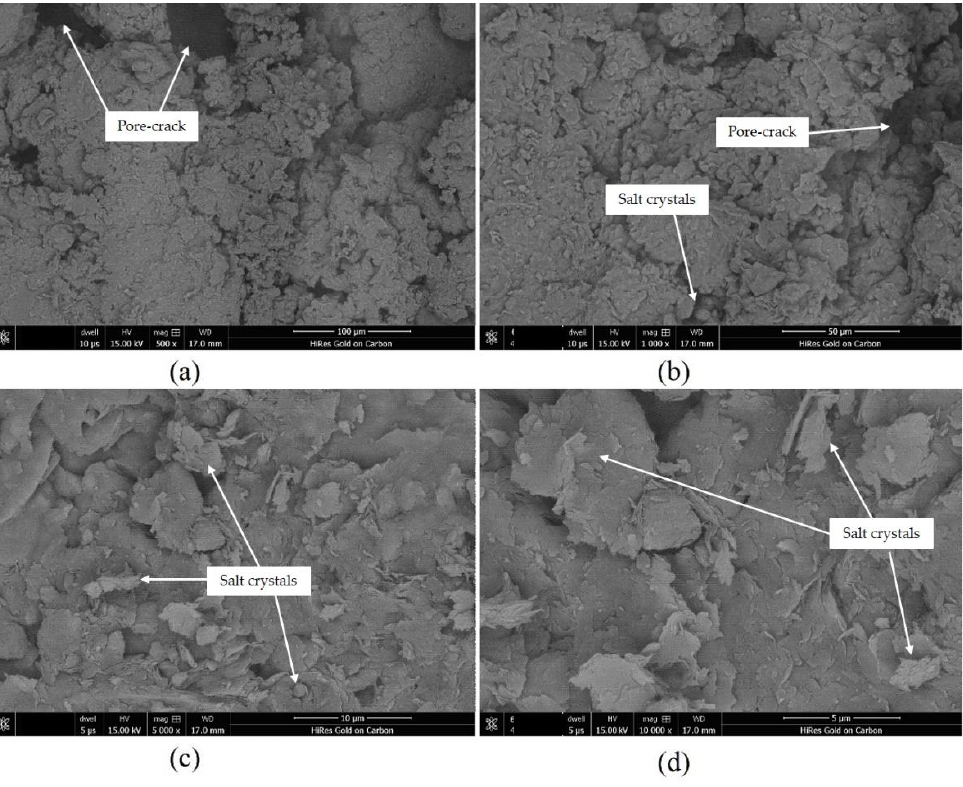
Figure 6. SEM images of specimens (S = 2.1%) subjected to freeze-thaw cycles (FTCs = 30) with different magnifications. Notes: ( a ) 500 × image; ( b ) 1000 × image; ( c ) 5000 × image; and ( d ) 10,000 × image.